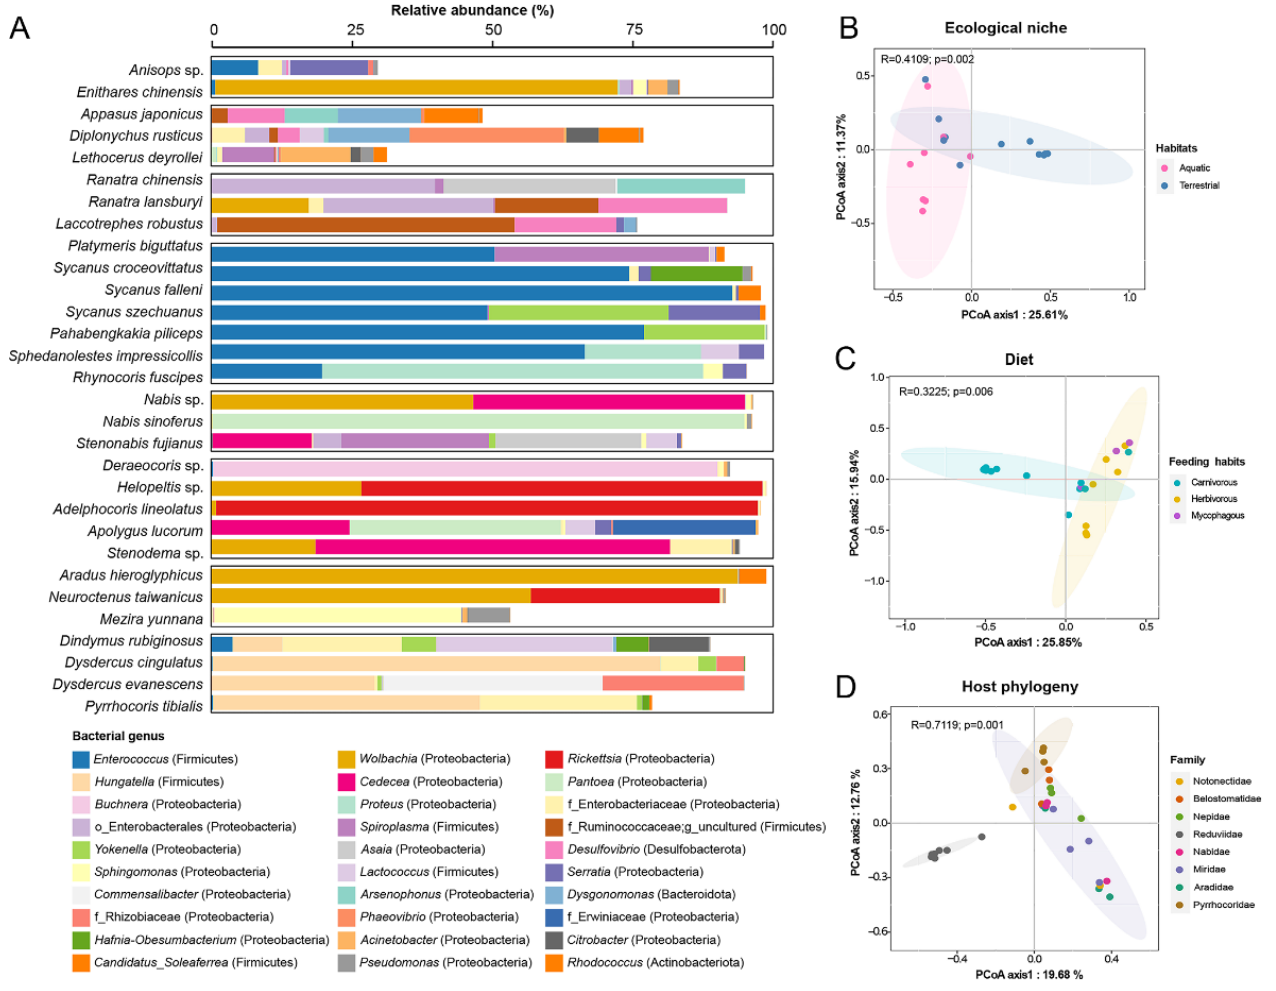
Figure 2. The gut bacterial community profiles differed between environmental habitats and across host taxonomy. ( A ) The frequency of the top 30 most abundant bacterial genera across different species. For the reads that were not able to be assigned to the taxonomic scale of genera, the family name prefixed by the letter “f” is given. ( B – D ) The PCoA clustering based on the Bray–Curtis distances of the microbiota of carnivorous true bugs between aquatic and terrestrial habitats ( B ), terrestrial true bugs of different diets ( C ), or different families ( D ). Table 1. Richness and diversity of the gut bacterial community.